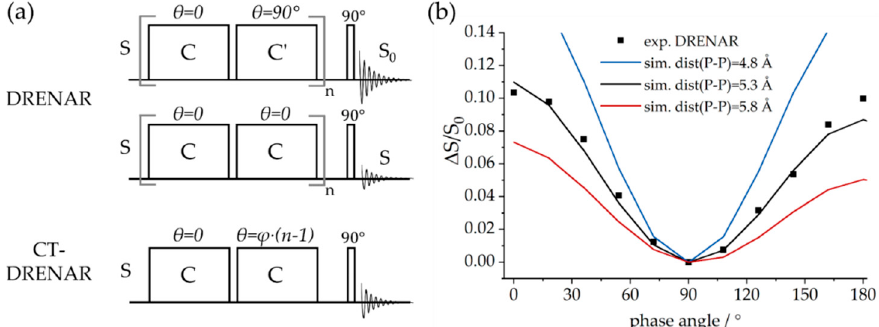
( a ) Dipolar re-coupling e ff ects nuclear alignment reduction (DRENAR) (top) and constant-time (CT)-DRENAR (bottom) experiments based on reduction of longitudinal magnetization by excitation of double quantum (DQ) coherence using the homonuclear dipolar coupling interaction. While, in the standard DRENAR experiment, the indirect dimension is incremented by adding DQ excitation blocks, in CT-DRENAR, the relative phase of the second excitation block is incremented by an arbitrary angle ϕ . ( b ) Exemplary CT-DRENAR spectrum for one phosphorus species in an FLP macrocycle further discussed in Section 3.6. Additionally, simulated CT-DRENAR curves for internuclear distances of 4.8, 5.3, and 5.8 Å are